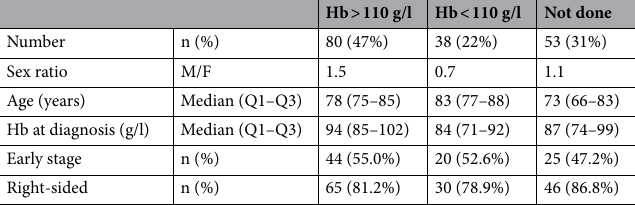
Table 3. Descriptive statistics for the IDA group (n = 171) by outcome of the last blood count in the 2 years prior to presentation with CRC.